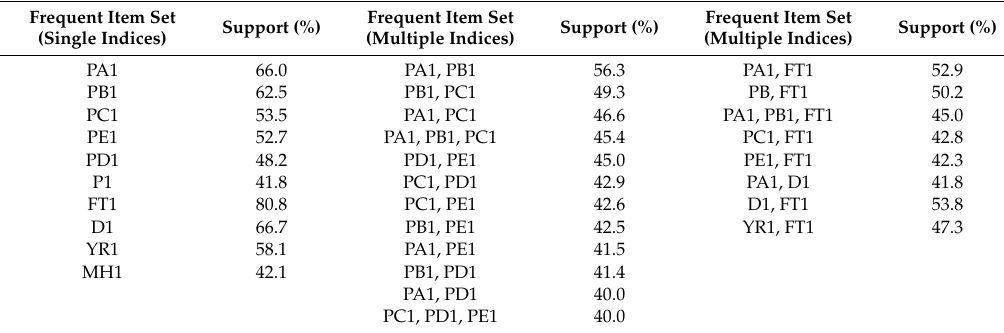
Table 3. Frequent item sets for the rainfall